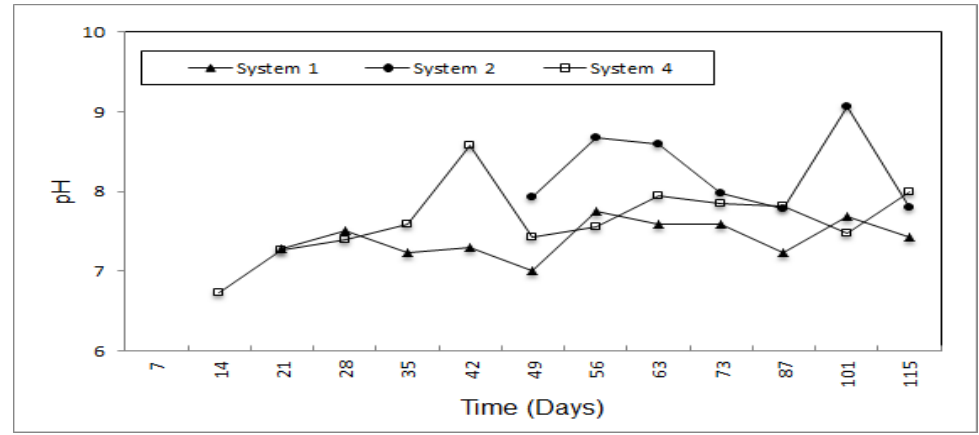
Figure 3. Variation of pH for system 2 and system 3 versus system 1.